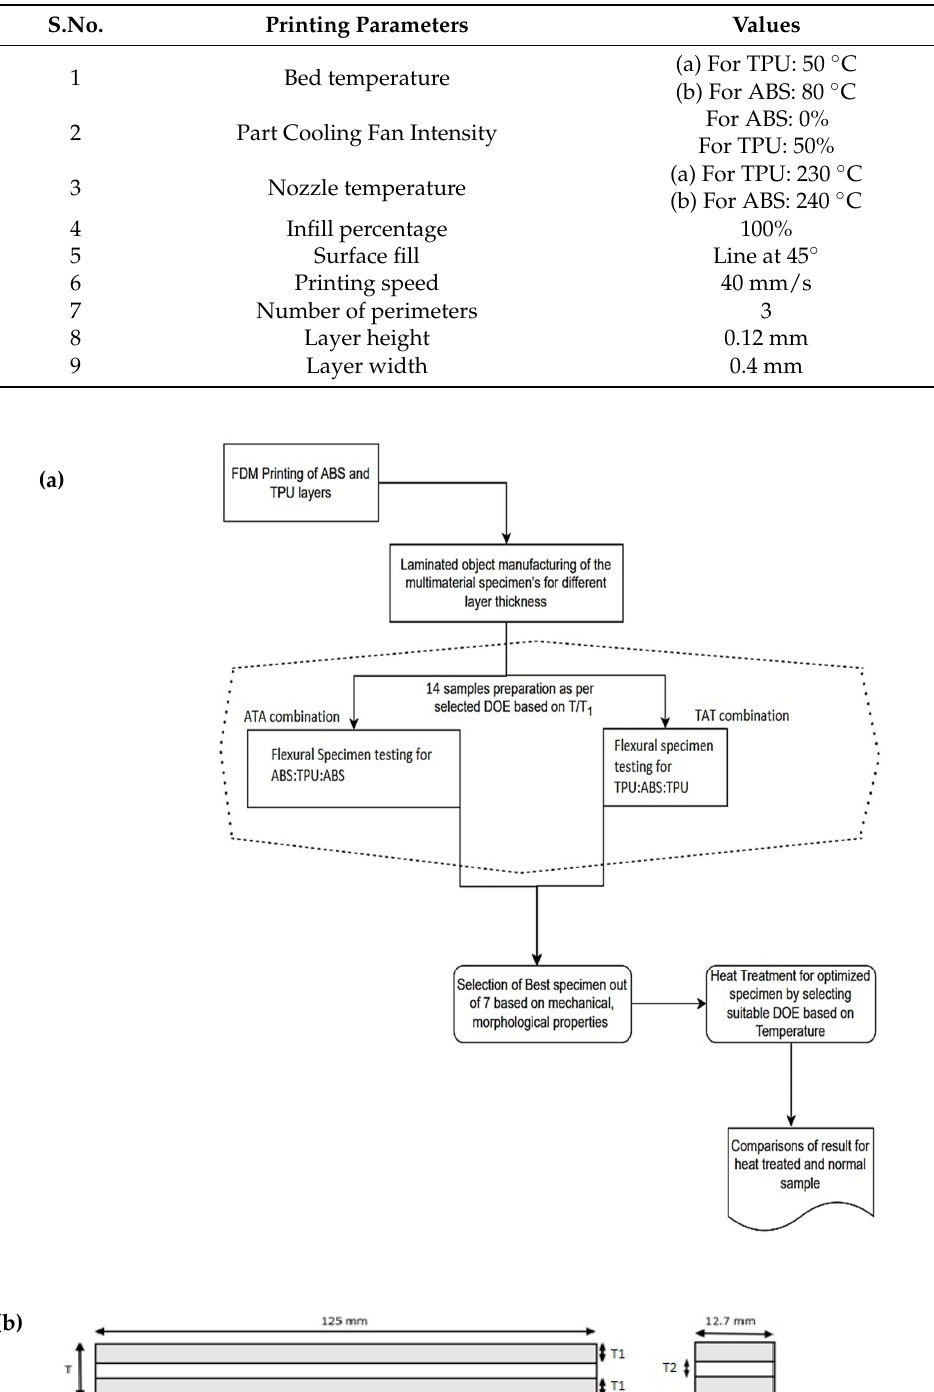
Table 2. Fixed 3D printing parameters used for sample preparation.